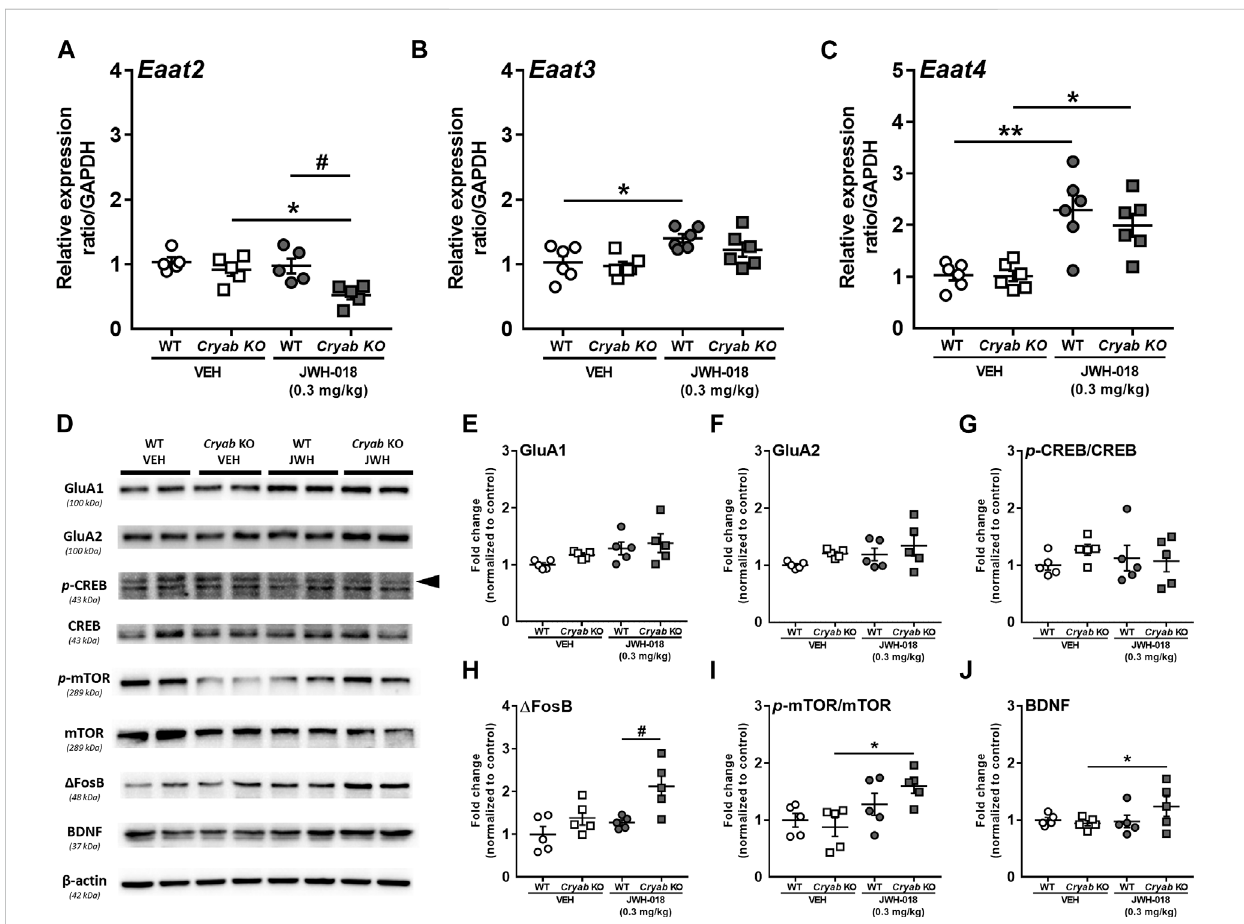
FIGURE 6 Glutamate transporter mRNA levels and plasticity-related protein expressions in wild-type (WT) and Cryab knockout (KO) mice following JWH-018 exposure. mRNA expression levels of (A) Eaat2 (B) Eaat3 , and (C) Eaat4 in JWH-018-exposed mice was determined by quantitative real-time polymerase chainreaction. n =5 – 6. (D) RepresentativeblotsshowingtheexpressionoftargetproteinsinmiceSTR.Westernblottingrevealedtheexpressionlevelsof (E) GluA1, (F) GluA2, (G) p -CREB/CREB, (H) Δ FosB, (I) p -mTOR/mTOR,and (J) BDNFintheSTRofJWH-018-exposedmice. n =4 – 5.Dataexpressed as mean ± S.E.M. * p < 0.05 and ** p < 0.01 (vs. VEH; Tukey ’ s post hoc analysis). # p < 0.05 (vs. WT; Tukey ’ s post hoc